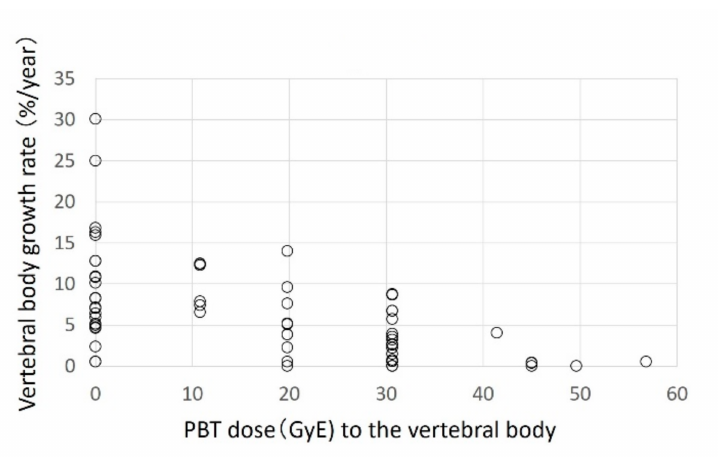
Figure 3. Lumbar vertebral